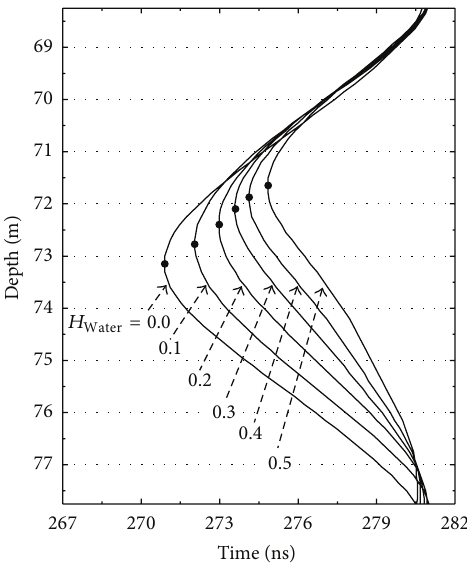
Figure 4: The time of peak (TOP) profiles extracted from the B- scan images for 6 different height ratios of water inside the tunnel ). The fastest arrival of each TOP profile is marked by a block ( 𝐻 Water